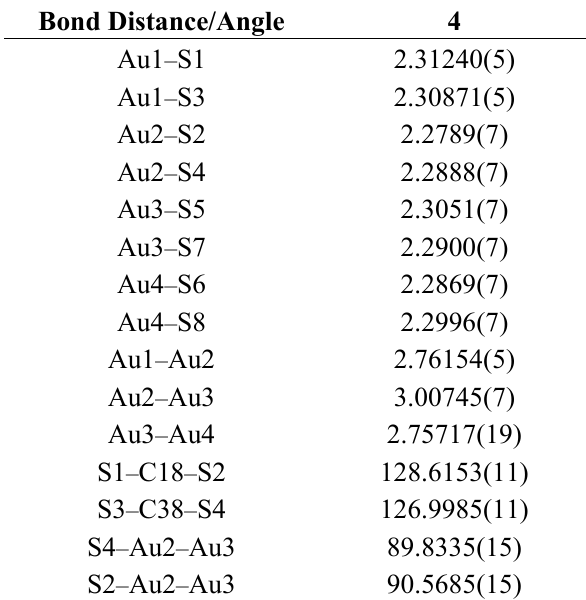
Table 1. Selected bond lengths (Å) and angles (°) for complex 4